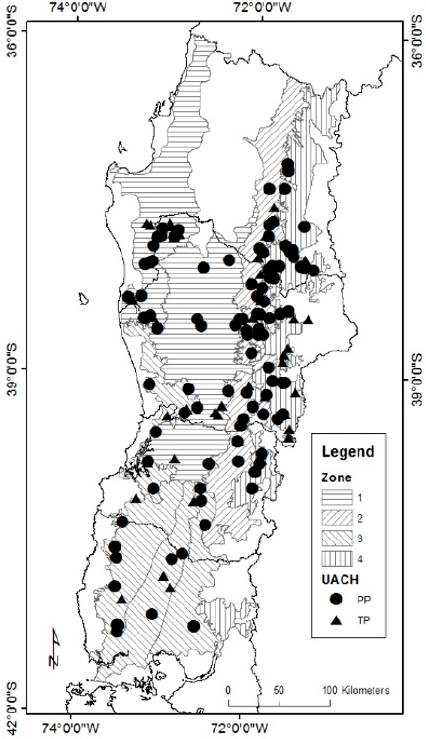
Figure 1. Geographical localization of permanent plots (PP) and temporary plots (TP) networks. Growth zones defined by Gezan and Moreno [11] are also shown. Each plot from the PP network had an area of 500 m 2 , but for higher densities (>4800 trees ha − 1 ) plot area was reduced to 250 m 2 . All trees with a DBH of 5 cm or larger, and taller than 2 m in height were measured. Total height was obtained in a subsample of 15 trees per plot, and tree increment cores were extracted from this subsample at DBH to estimate breast height age and obtain past diameter growth. The plots from the TP network were formed by two circular subplots with an area of 125 m 2 each. As with the PP network, all trees with DBH > 5 cm and taller than 2 m were measured. In each subplot, two trees were felled for complete stem analysis. Further details of these datasets are presented in Gezan and Moreno [11]. This study used annual average DBH growth based on the last years, which originated from the increment cores (PP network) and tree sections (TP network) at breast height of the penultimate and antepenultimate growth years. The last growth year was discarded as plots were established at different months within a year, without all completing the current growing season.